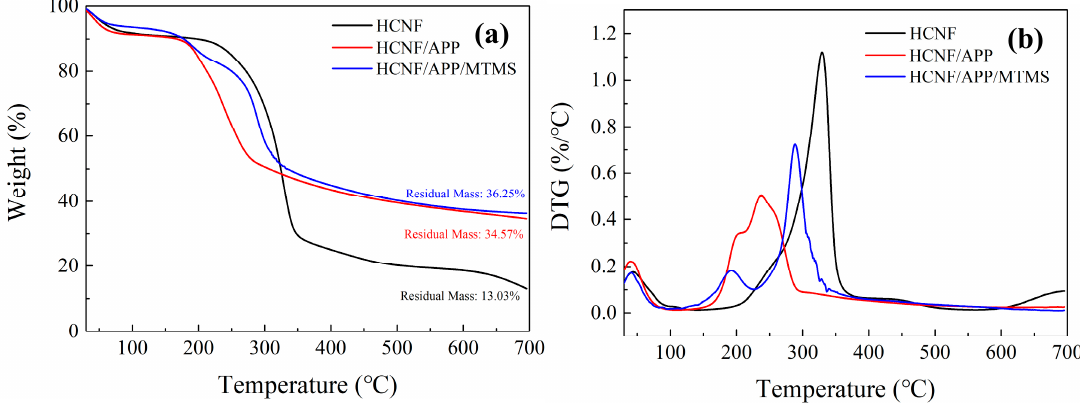
Figure 5. The TGA ( a ) and DTG ( b ) curves of HCNF, HCNF/APP, and HCNF/APP/MTMS aerogels. Table 2. TGA data of HCNF, HCNF/APP, and HCNF/APP/MTMS aerogels. Samples